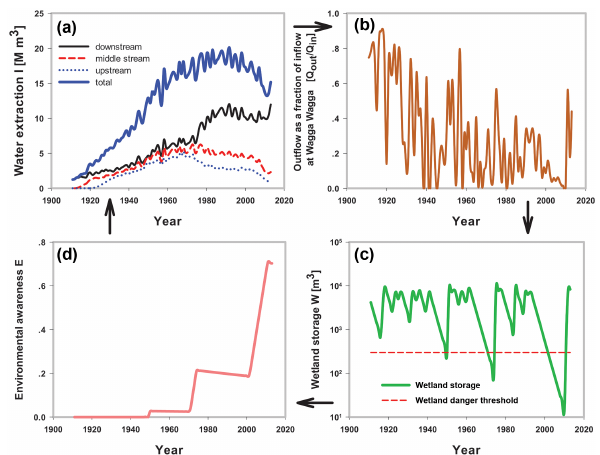
Figure 10. Time variation ecology-environmental awareness: (a) rates of water extraction in the three settlement and total rate of water extraction; (b) environmental (out)flow to downstream wet- lands as a ratio of inflow at Wagga Wagga; (c) wetland storage and wetland danger threshold; and (d) environmental